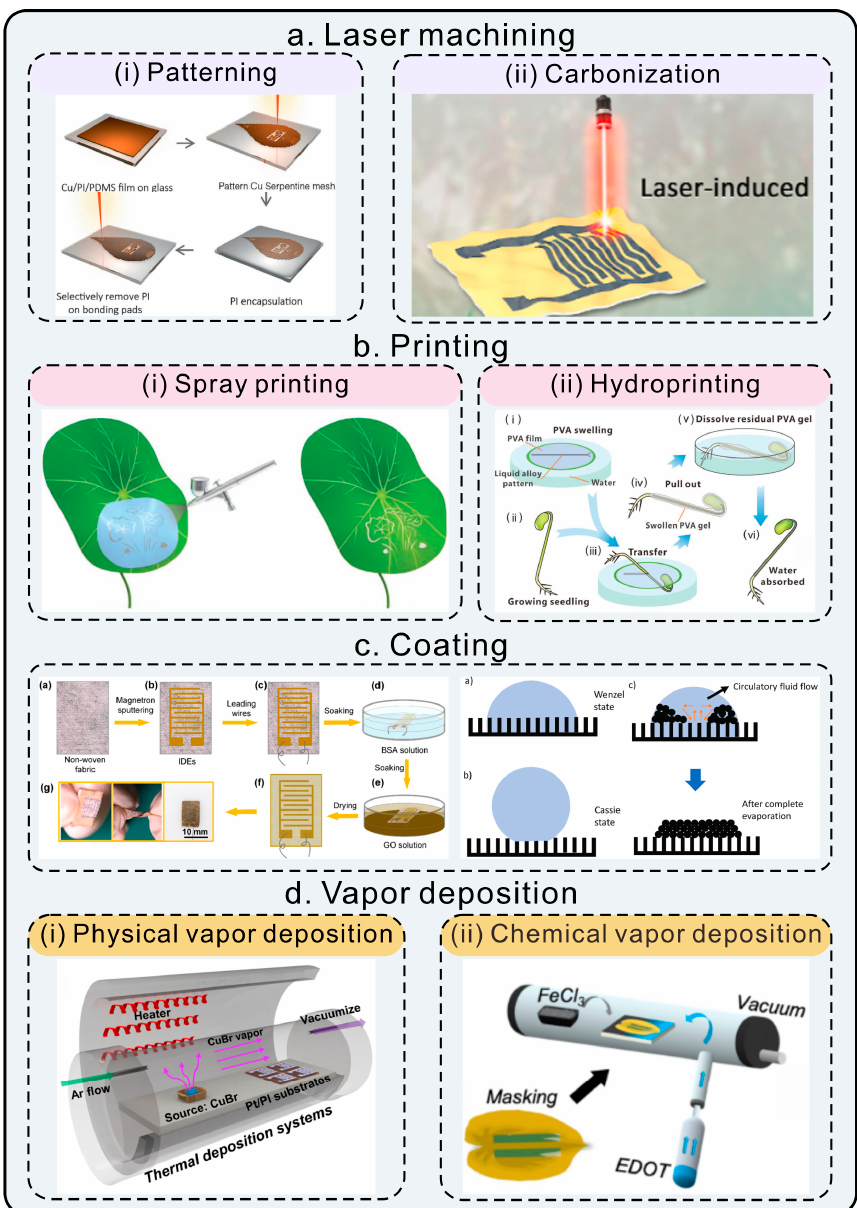
Figure 3. Various fabrication processes for soft fi lm sensors. ( a ) Laser machining. (i) Pa tt erning